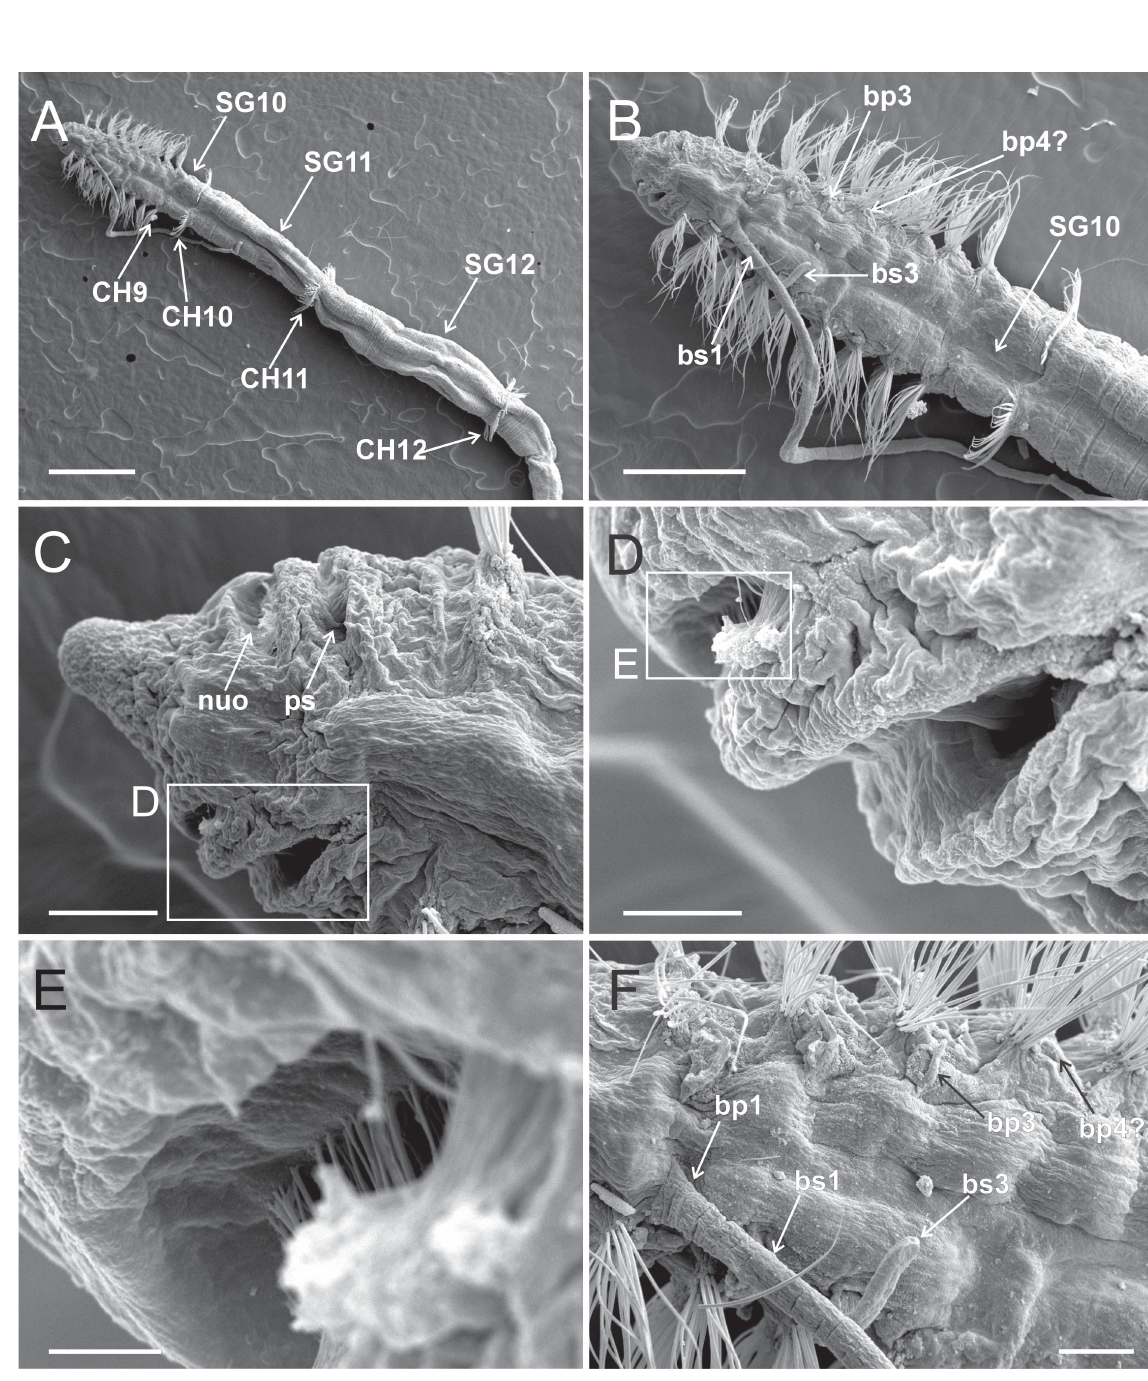
Fig. 6. Heterospio indica sp. nov., paratype (MNCN 16.01/17000), SEM micrographs. A . Anterior end, dorsal view (scale bar = 500 m m). B . Detail of anterior short segments (SG1−SG9) and first elongated segment (SG10) (scale bar = 250 m m). C . Anterior end, dorsal view, showing nuchal organ and palp scars, framed area shown in (D) (scale bar = 50 m m). D . Detail of nuchal organ and palp scar, framed area shown in (E) (scale bar = 20 m m). E . Detail of nuchal organ opening (scale bar = 5 m m). F . Detail of branchial area, dorsal view (scale bar = 50 m m). Abbreviations: bp = branchiophore; bs = branchiostyle; CH = chaetiger; nuo = nuchal organ; ps = palp scar; SG =